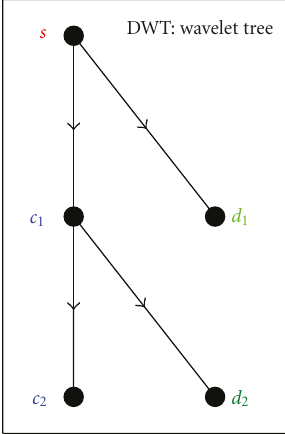
Figure 1: Wavelet decomposition tree at 2 levels. Symbol s represents microarray profiles; c 1 and d 1 represent approximation coe ffi cients and detail coe ffi cients at 1st level; c 2 and d 2 represent approximation coe ffi cients and detail coe ffi cients at 2nd